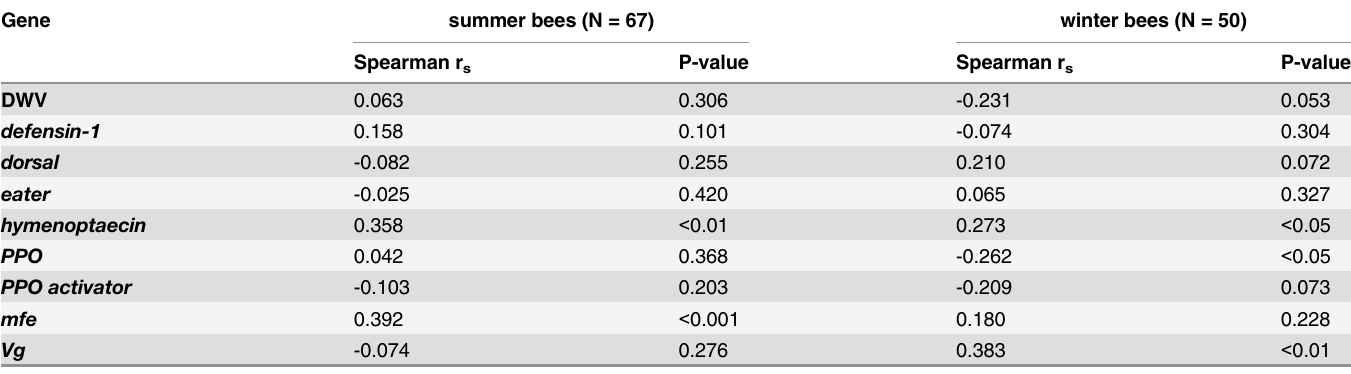
Table 4. Spearmans r s correlation of gene expression with worker age on summer and winter bees.